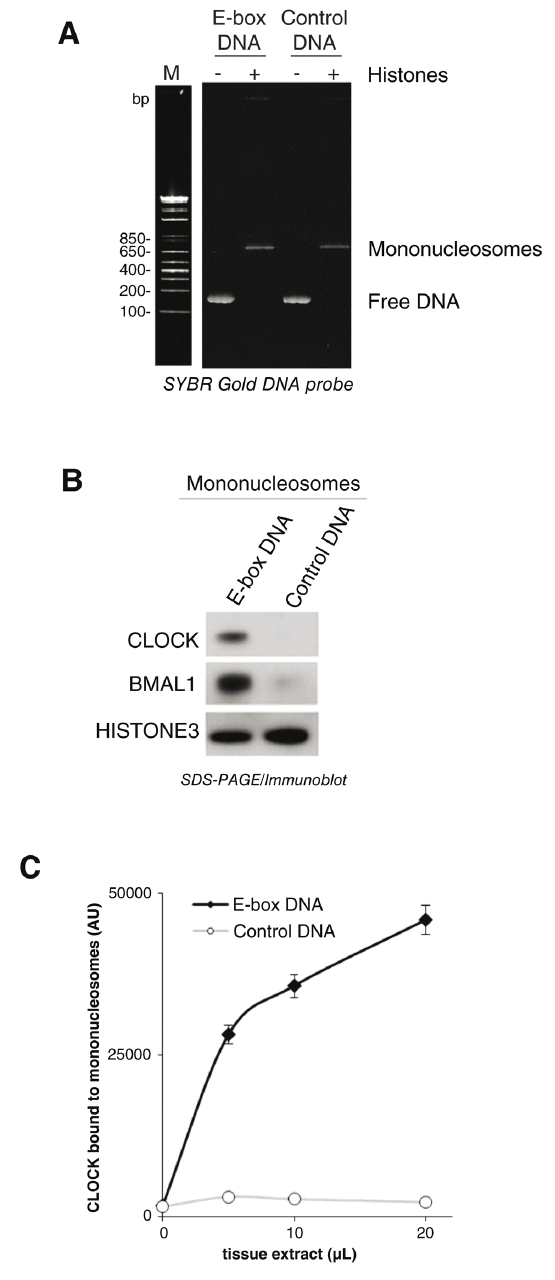
Figure 4. Modified CPDBA used to Quantitate CLOCK-BMAL1 Binding to Mononucleosomes. ( A ) Free dsDNA containing E-box DNA or scrambled E-box DNA (Control DNA) was incubated with or without core histones, and reconstituted mononucleosomes were analyzed using CN-PAGE stained with SYBR gold. ( B ) Immobilized mononucleosomes were incubated with liver nuclear extracts. CLOCK-BMAL1 binding to mononucleosomes was assessed using SDS-PAGE/immunoblotting for CLOCK, BMAL1, and HISTONE3. ( C ) Immobilized mononucleosomes were used in place of naked DNA in CPDBA to measure CLOCK binding to E-box DNA within mononucleosomes using a series of nuclear extract concentrations